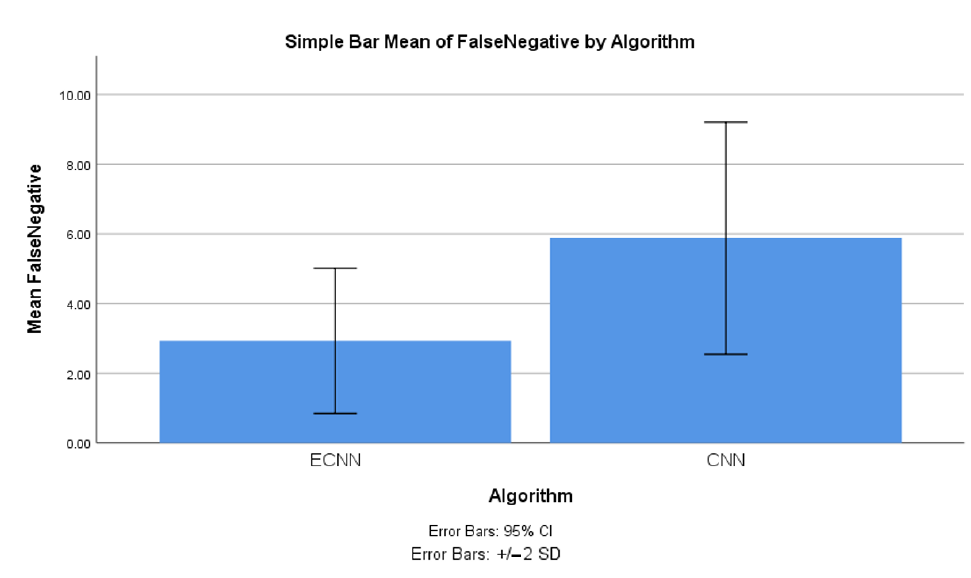
Figure 10. Mean false-negative comparison.